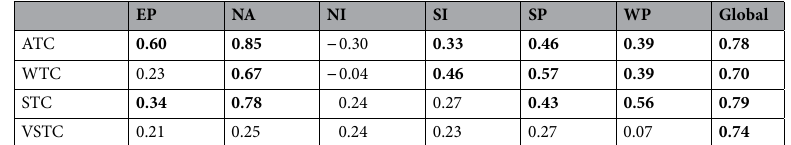
V land and TC duration over land. Bolded numbers indicate statistically (cid:31)